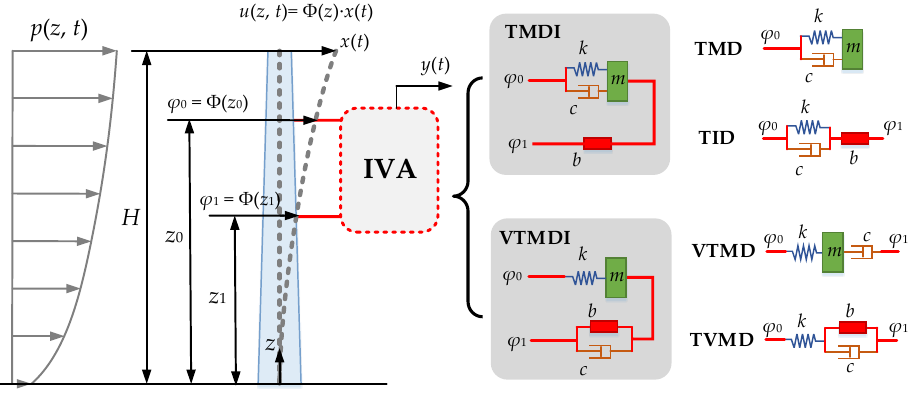
the generalized coordinate (height) z (0 ≤ z ≤ H, Φ( H ) = 1), and a time dependent general- ized displacement response x ( t ), i.e., u ( z , t ) = Φ( z )· x ( t ). Note that x ( t ) is exactly equalled to displacement response x ( t ), i.e., u ( z , t ) = Φ ( z ) · x ( t ). Note that x ( t ) is exactly equalled to the the top displacement, x ( t ) = u ( H , t ). top displacement, x ( t ) = u ( H , t ).